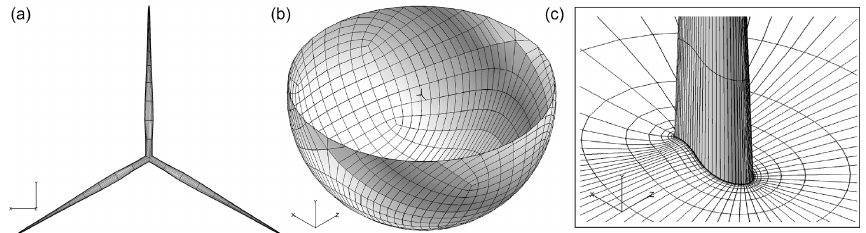
Figure 7. Visualization of straight blade CFD mesh. (a) Blade surface mesh (for clarity, only 1 out of 16 grid lines shown). (b) Lower half of outer domain surface mesh (1 out of 16 grid lines). (c) Detail of volume mesh, cut at mid-span (1 out of 8 grid